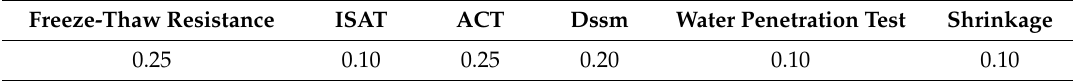
Table 5. Proposed values of weight coe ffi cient α